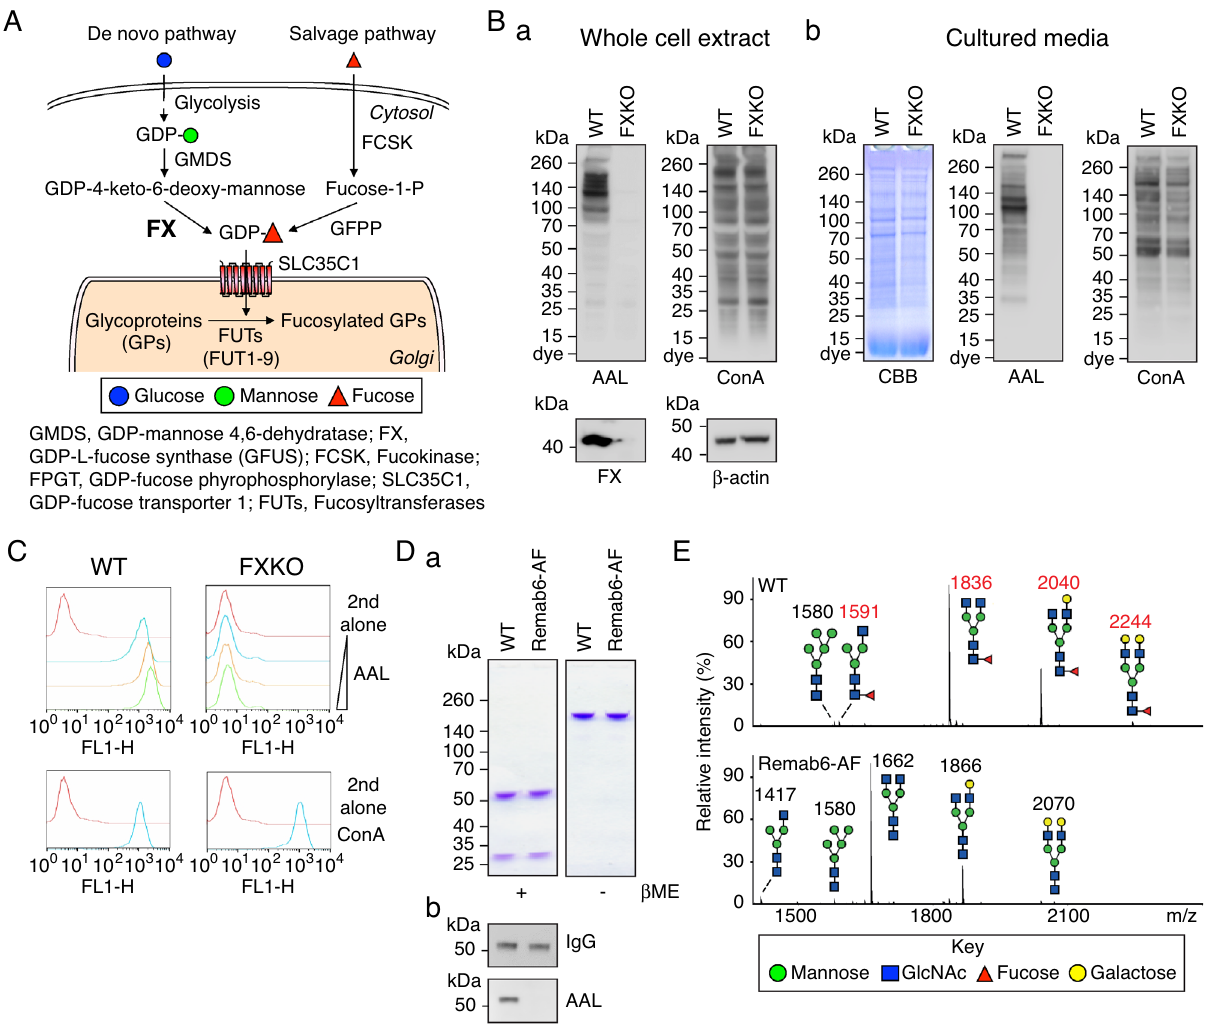
Figure 1. Establishment of FX knockout cell line ( FXKO ) and generation of glycoengineered anti-Tn mAb. ( A ) A depiction of the L-fucose metabolic pathway in mammalian cells. ( B ) The FX gene knockout HEK293 free style cell line ( FXKO ) generated using Crispr/Cas9 system. Total cell extracts ( a ), or cultured media ( b ) from WT and FXKO cells analyzed on SDS-PAGE gel and Western and lectin blots with FX, β-actin, AAL, or ConA. SDS-PAGE gel for cultured media stained with Coomassie brilliant blue (CBB) as a loading control. ( C ) Fucosylation levels on cell surface analyzed by flow cytometry with AAL lectin (a 1:3 dilution ratio starting at 10 μg/mL); ConA used as a control. ( D ) Remab6, a chimeric anti-Tn IgG1 mAb, produced in WT and FXKO cell lines (Remab6-AF), and analyzed on SDS-PAGE gel under reducing (βME+) or non-reducing condition (βME−) stained by CBB (a) , and fucosylation levels on their Remab6 analyzed by Western and lectin blots with human IgG or AAL (b) . ( E ) N-glycome analysis of WT- or Remab6-AF produced as in ( D ) by MALDI-TOF– MS. The relative intensity of the most abundant peak in each spectrum set as 100% ( m/z 1836, WT; m/z 1662, Remab6-AF), and selected peak masses annotated as structural features such as fucosylated (red) and non- fucosylated glycans (black). All images except Western and lectin blot (n = 3) are shown as one representative of two independent experiments (n =